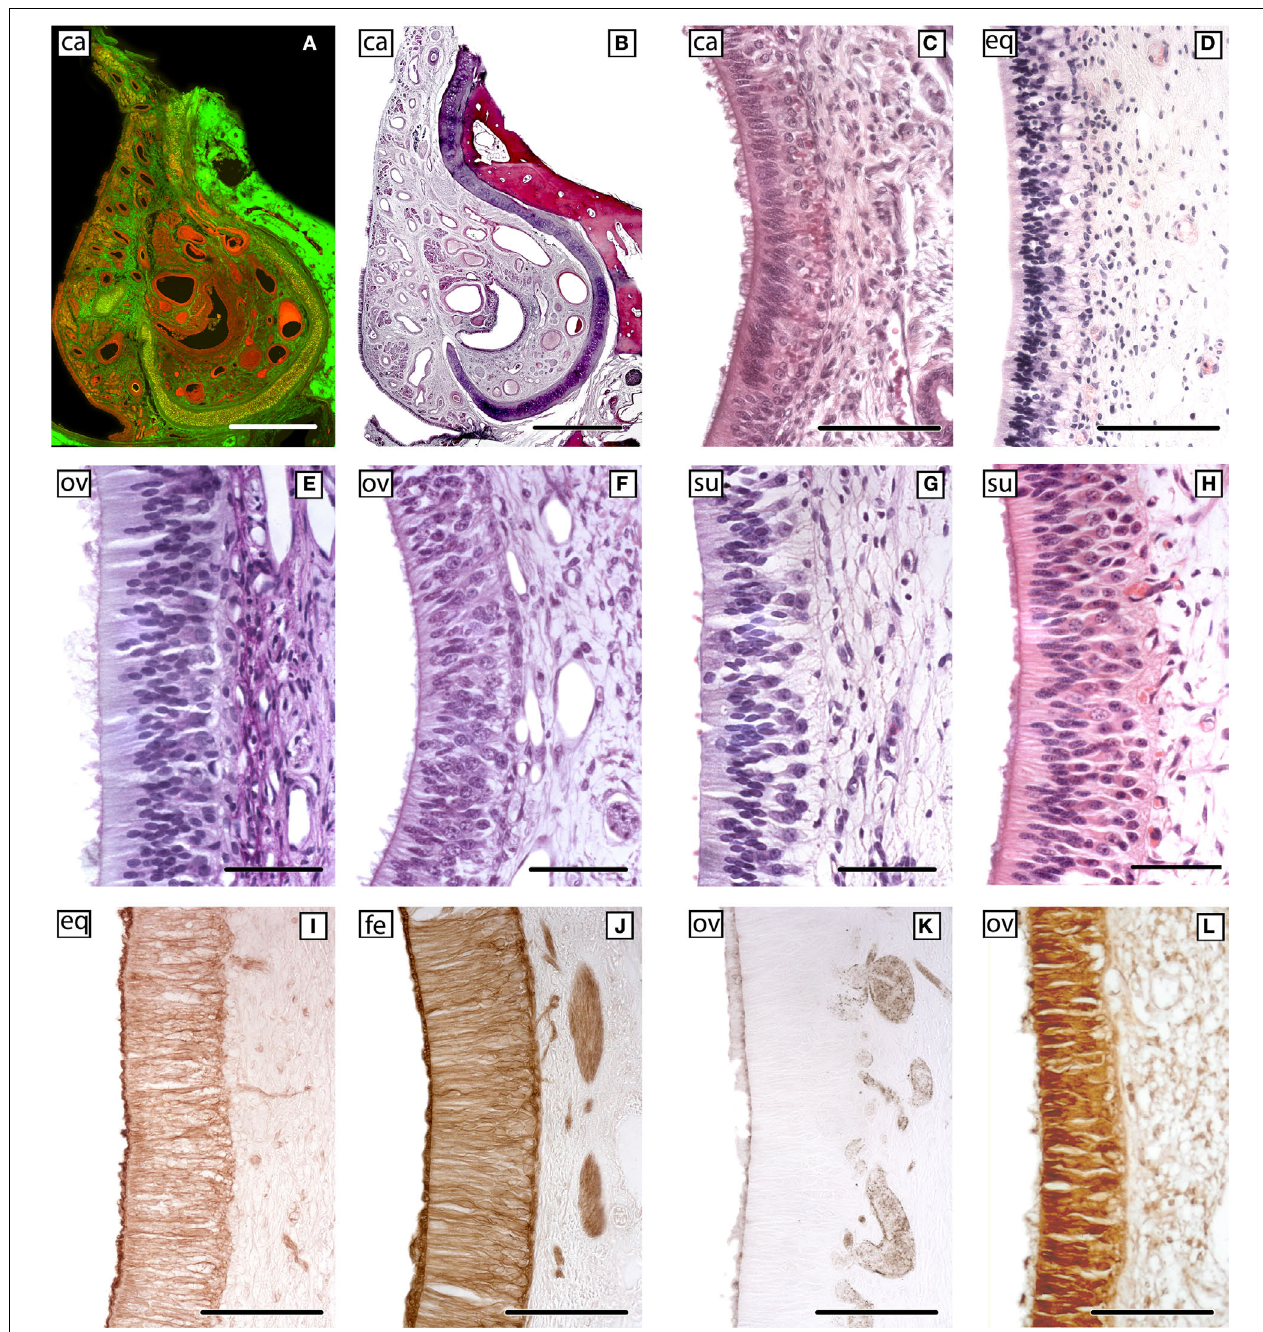
FIGURE 4 | The sensory epithelium of the VNO of certain domestic mammals. (A,B) The VNO of the dog (ca) is shown by autofl uorescence imaging (A) and hematoxilin-eosin staining (B) in two adjacent sections of the same specimen. (C–H) Haematoxylin-eosin transverse sections of the VNO of the dog (ca) (C) , horse (eq) (D) , sheep (ov) (E) , 141-days-old sheep (ov) fetus